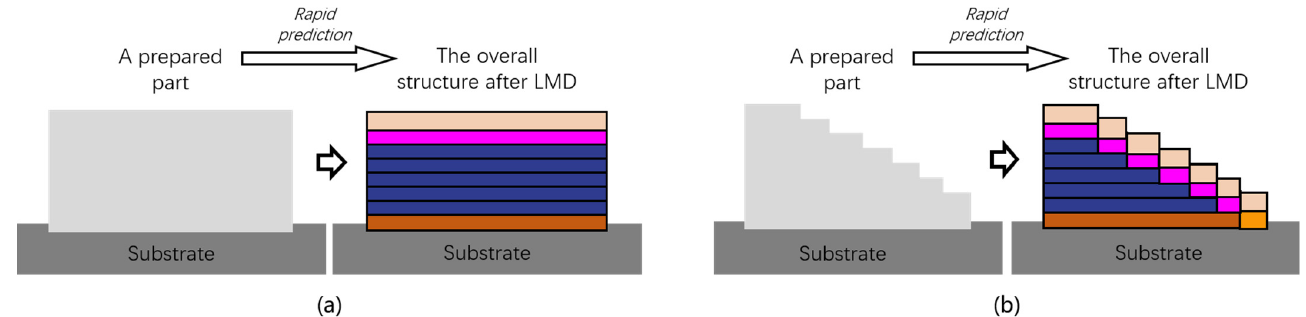
Figure 3. Prediction of the overall structure of fabricated components based on the structural evolution history of the heat-affected zone: ( a ) represents the prediction of a regular part; ( b ) represents the prediction of an irregular part.